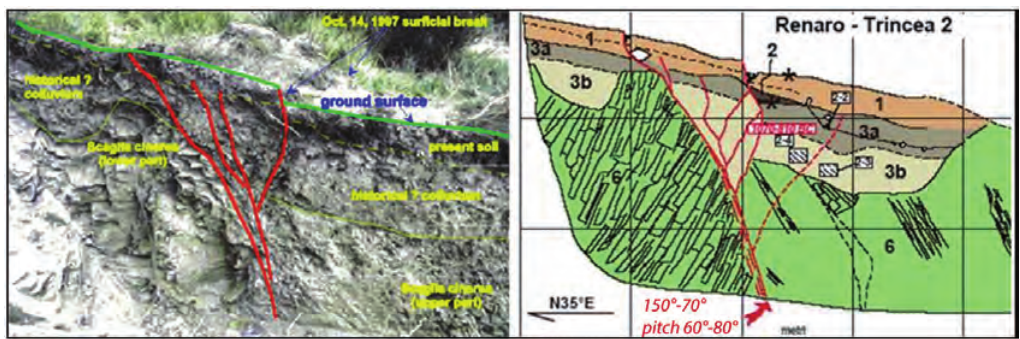
Fig. 14. View and log of the southern wall of the trench dug across the Renaro surface breaks (from Pantosti et al ., 2000). The 1997 breaks correspond at depth to a well-defined fault zone. Suggestion for the occurrence of an event before the 1997 event comes from the larger displacement of Unit 3a with respect to that of 1997, along with a buried colluvial wedge (unit